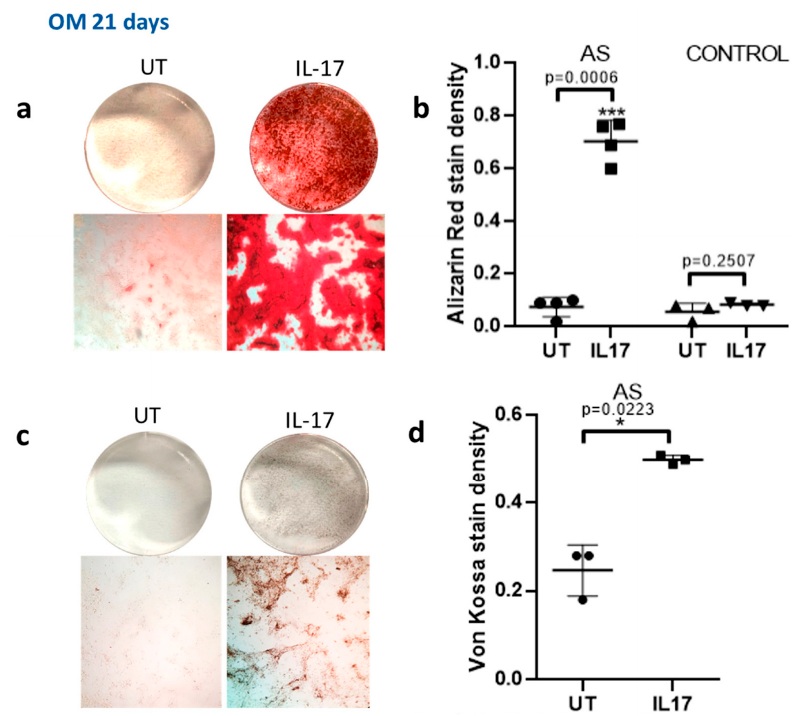
Figure 5. IL-17 induced mineralization in MSC cell cultures from AS group. MSCs were cultured in osteogenic medium (OM) for 21 days in the presence (IL-17) or absence (UT) of 50 ng/mL IL-17. ( a ) Alizarin red staining of AS cell cultures; macroscopic photographs (top row) and microscope images (bottom row). ( b ) Scatterplots depicting the quantification of Alizarin red stain density for AS and control group cell cultures. ( c ) Von Kossa staining of AS cell cultures; macroscopic photographs (top row) and microscope images (bottom row). ( d ) Densitometry analysis of Von Kossa stain. Mean ± SD. * = p < 0.05; *** = p <